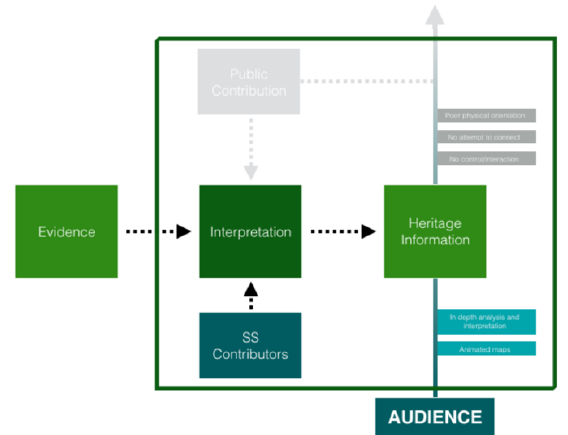
Figure 8. Singapura Stories Information Flow